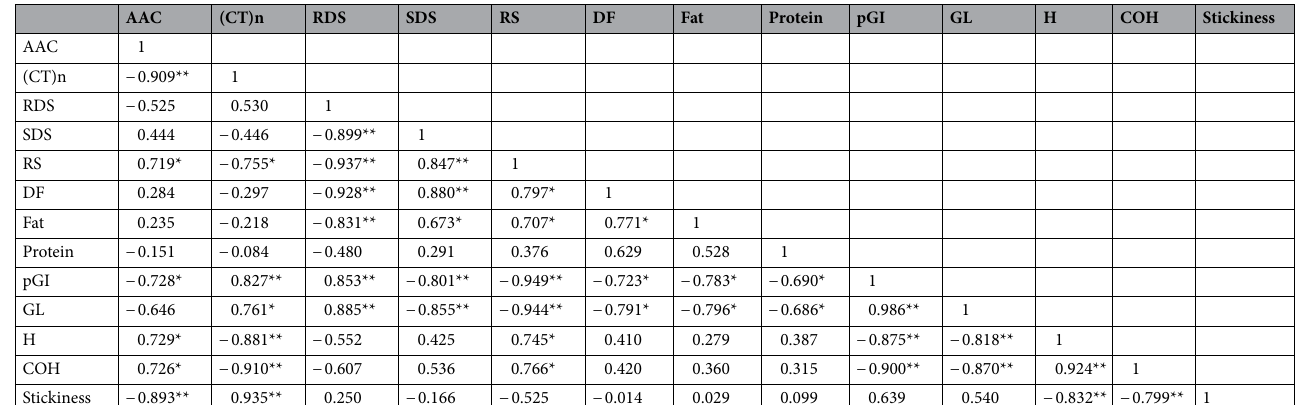
Table 3. Correlation matrix between various chemical and textural parameters. AAC apparent amylose content, (CT)n cytosine and thymine repeats, RDS rapidly digestible starch, SDS slowly digestible starch,